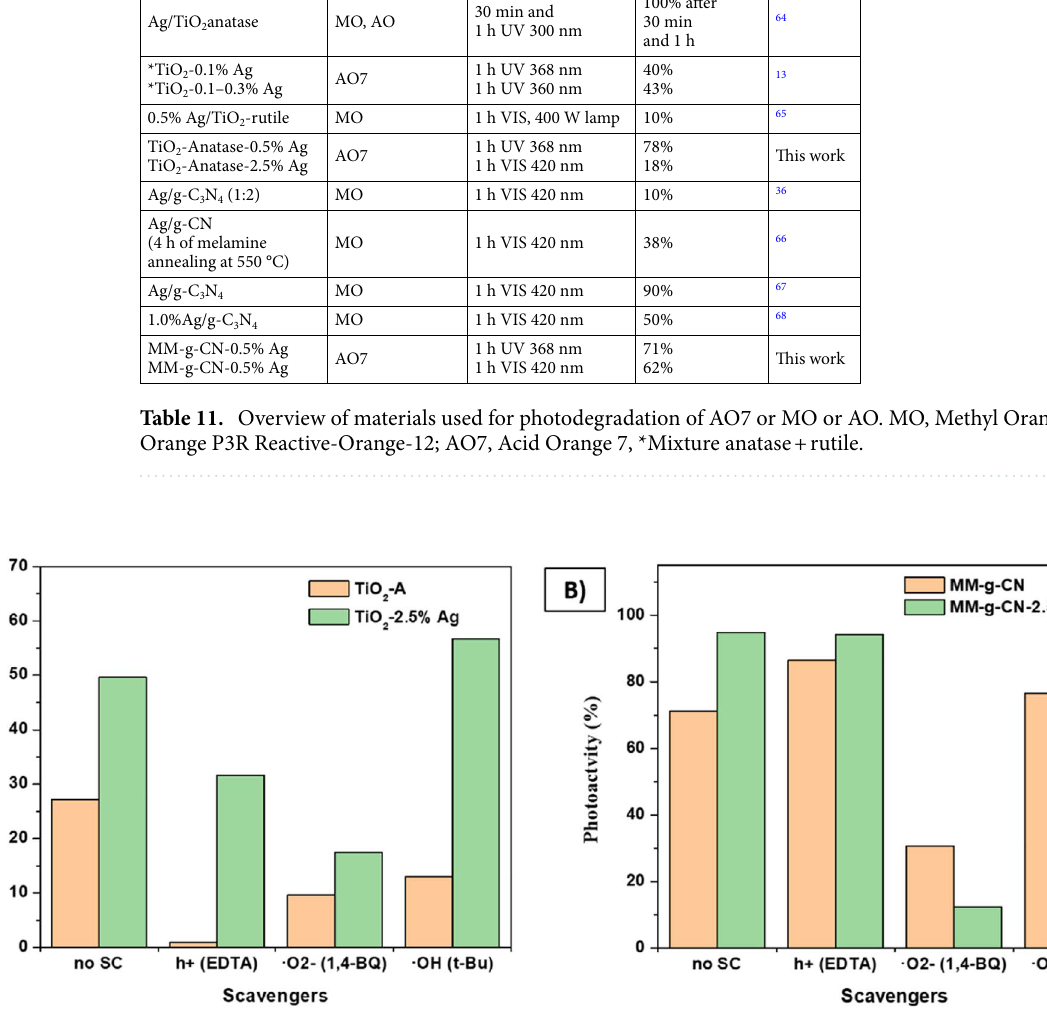
Figure 15. Effect of the presence of the scavengers on the photodegradation activity of: ( A ) TiO 2 -A and TiO 2 -A-2.5% Ag samples under UV irradiation and ( B ) MM-g-CN and MM-g-CN-2.5% Ag samples under VIS